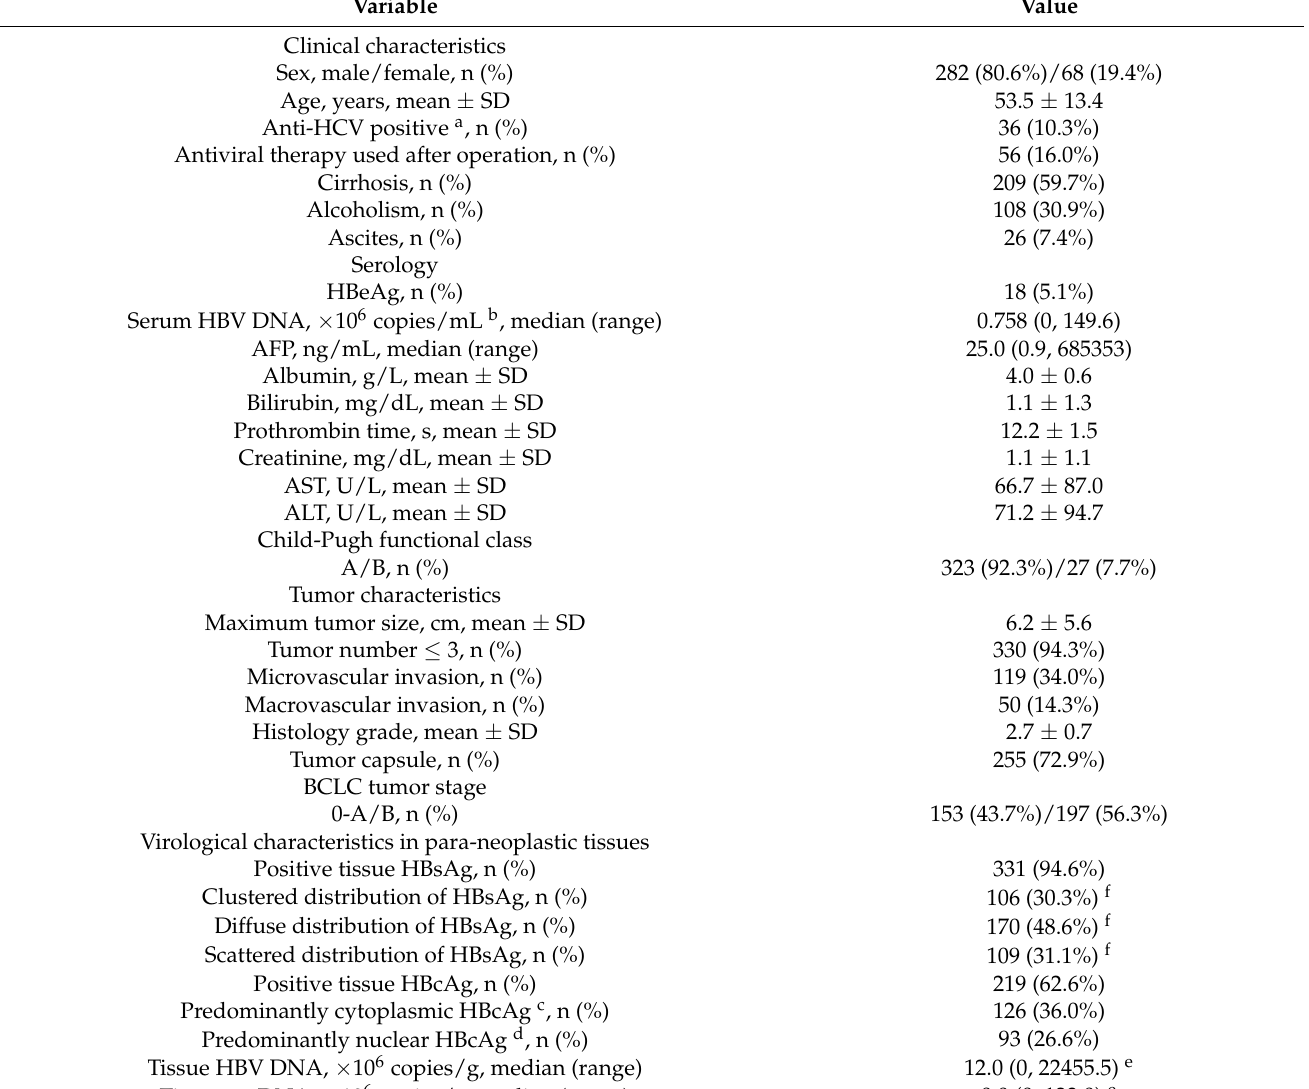
Table 1. Baseline data for 350 chronic hepatitis B patients with hepatocellular